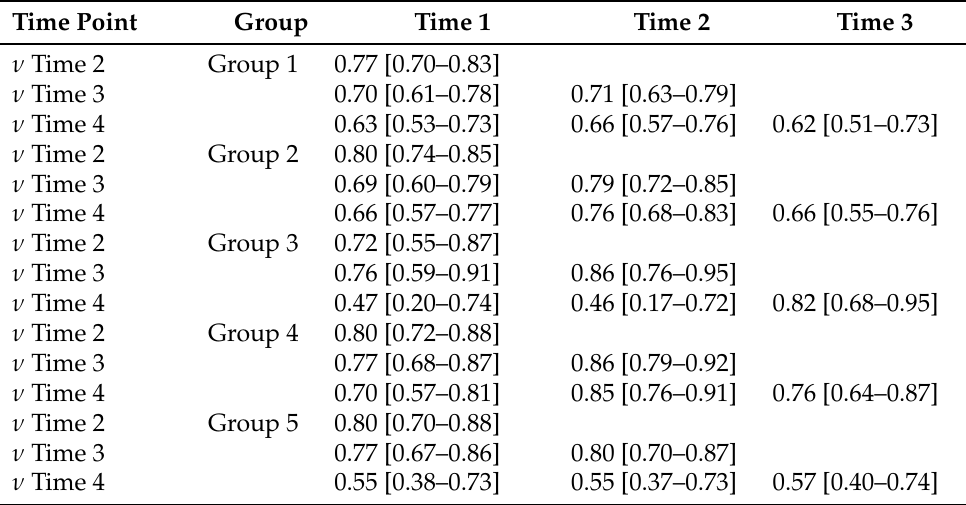
Table A7. Correlation matrix of drift rates across four time points split by